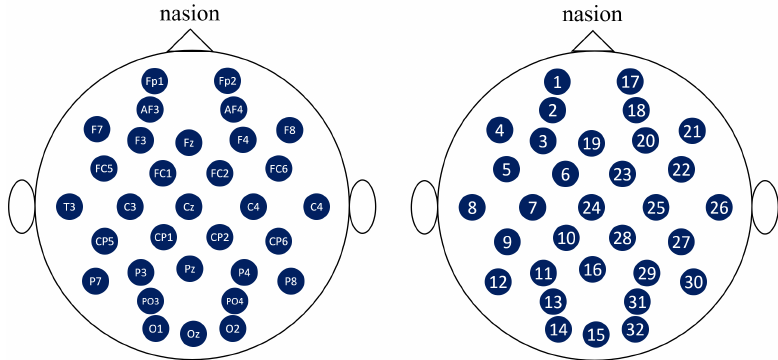
Figure 4. Electrode positions of the DEAP dataset. The positions are followed by an international 10-20 system. The locations of the nodes measured in the DEAP dataset are represented in the figure on the left, whereas the figure on the right shows the order of the nodes in the raw dataset. Note that the differences in the order values of the nodes do not match the distances at the actual